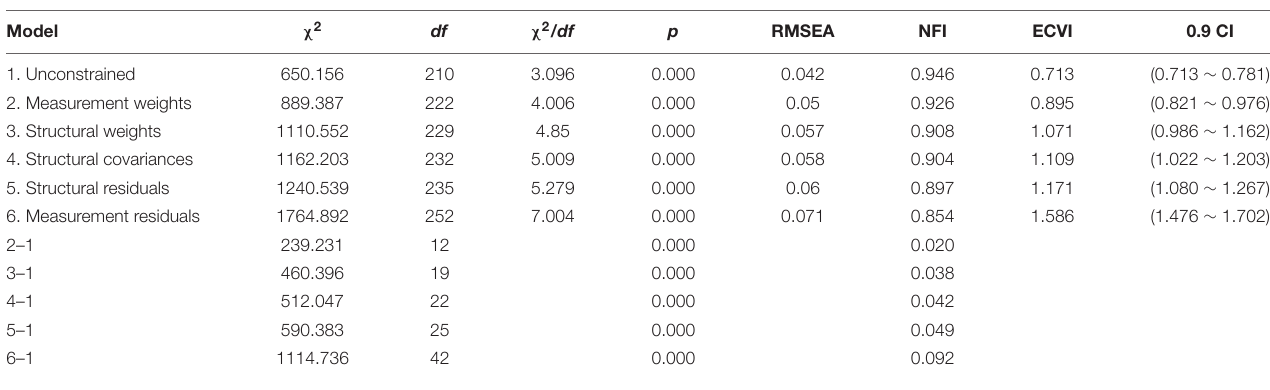
TABLE 3 | Multi-group